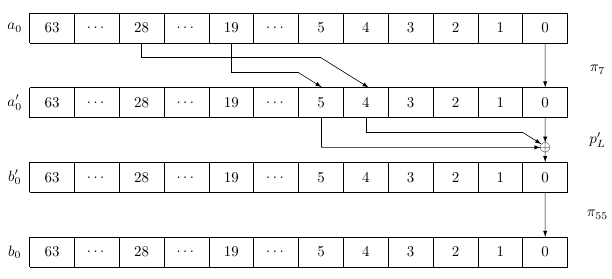
Figure 8: The linear mapping p L for row 0 can be seen as its alternative representation surrounded by two multiplication layers, illustrated for bit b p ′ L row 0. The list of parameters for the different rows of the alternative representation of p L with the minimum span are listed in Table 2. The alternative representation of p L T corresponds to the mapping obtained with − q .